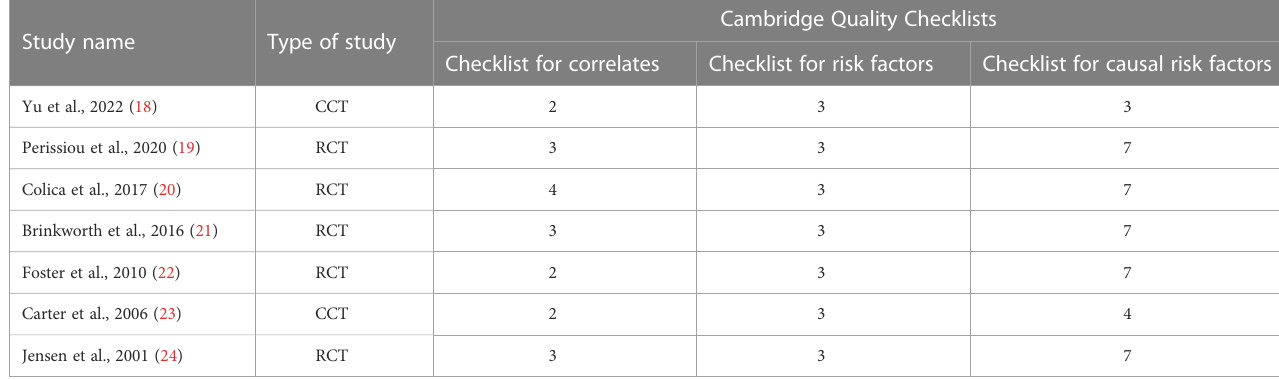
TABLE 2 Quality of evidence assessment of the included studies [results of the Cambridge Quality Checklist (17)].